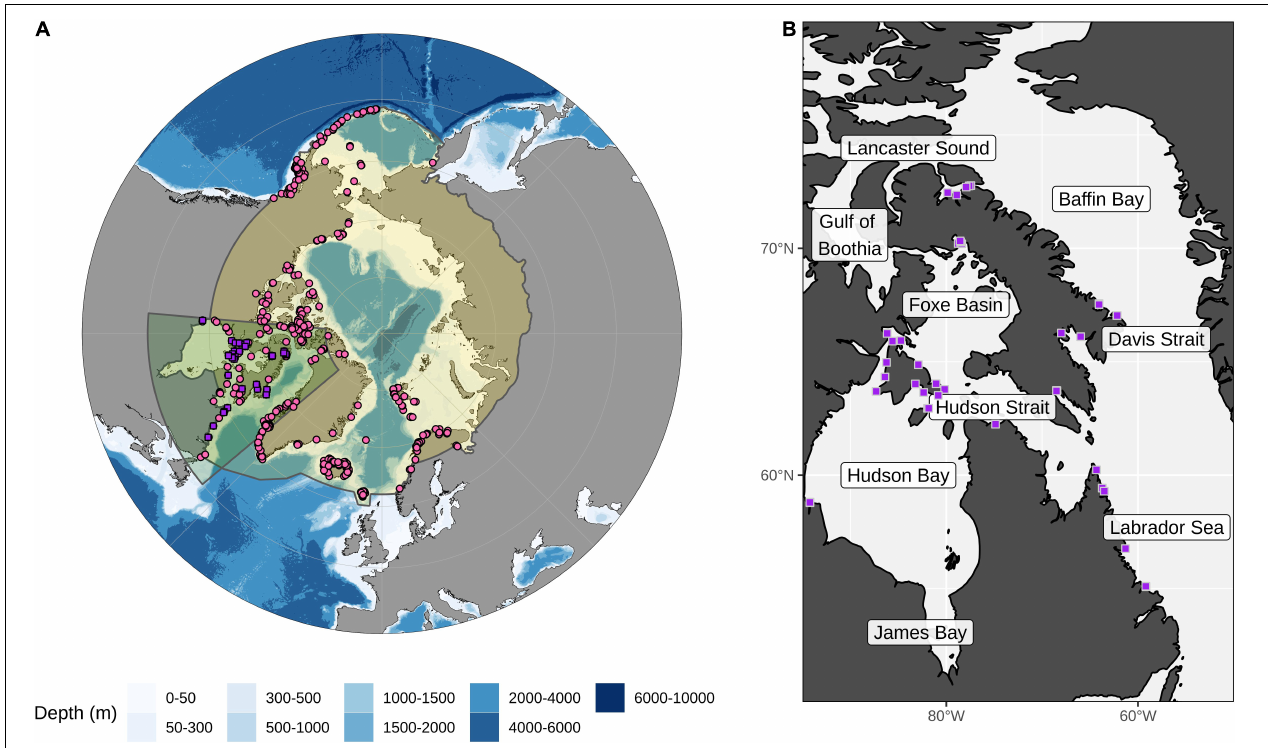
FIGURE 1 | Map of the Arctic and the focal area for this study. (A) The Arctic region is shown in yellow with the focal area of the study highlighted with a green polygon. Presence data points used in the ensemble model are shown as pink circles and purple squares (for details on the complete set of presence points included for each species see Supplementary Figure 1 ). (B) The study area shows the recent Arctic field campaign collection points (purple squares) for kelp coverage data used in the Random Forest and presence points for ensemble models (for details on sampling sites see Supplementary Table 1 ). Regions discussed in the text are